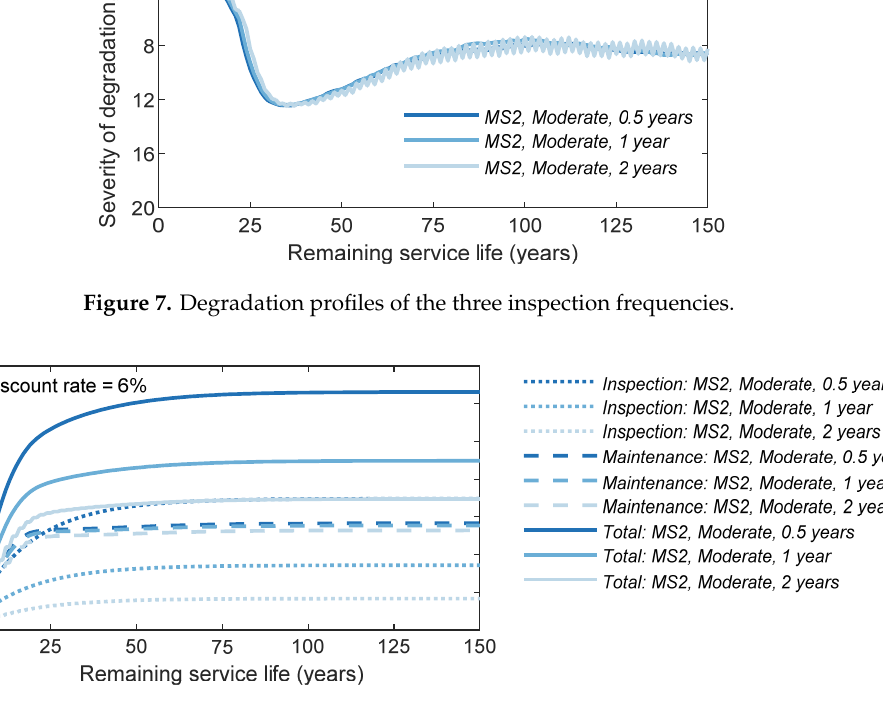
Figure 8. Cumulative cost (inspection, maintenance and total) profiles of the three inspection frequencies.